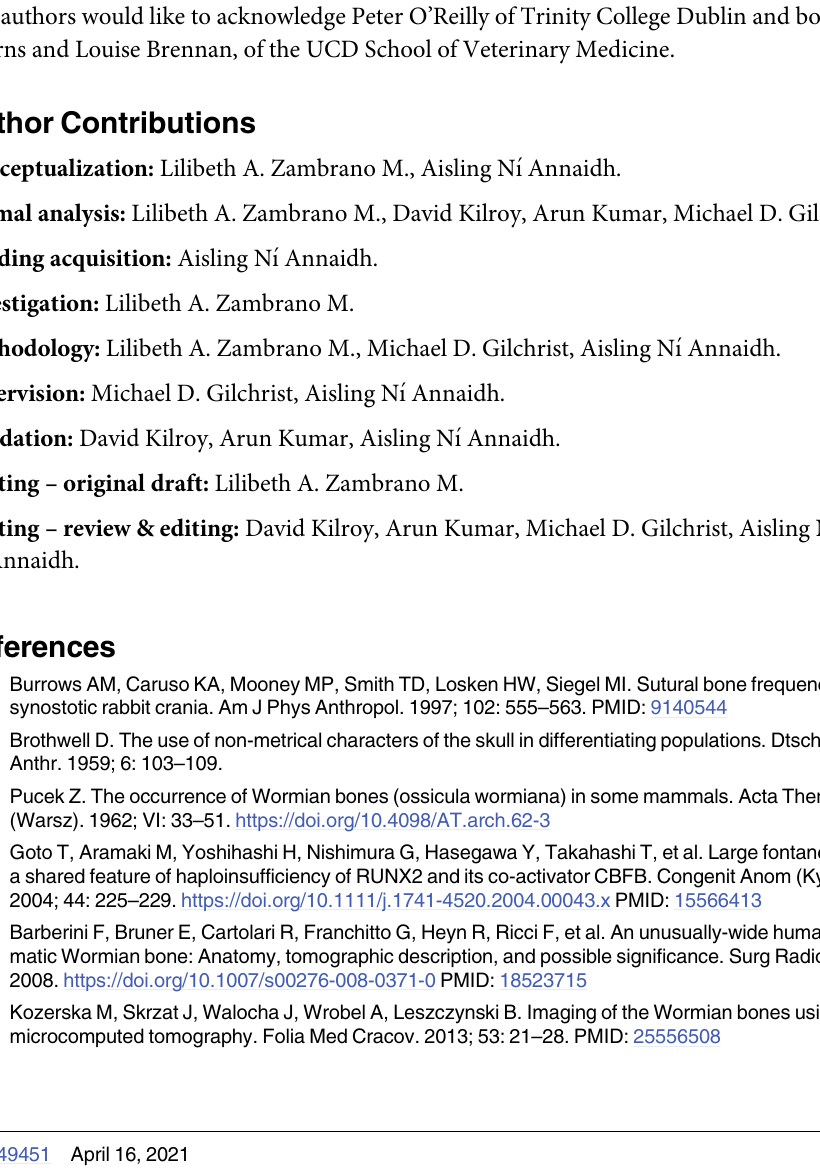
S1 Fig. Cross-section slice of an equine cranial bone sample showing a profile line report- ing the grey values for pixels in the trabecular bone zone. S2 Fig. Cross-section slice of an equine cranial bone sample showing a profile line report- ing the grey values for pixels in the Wormian (Intrasutural) bone